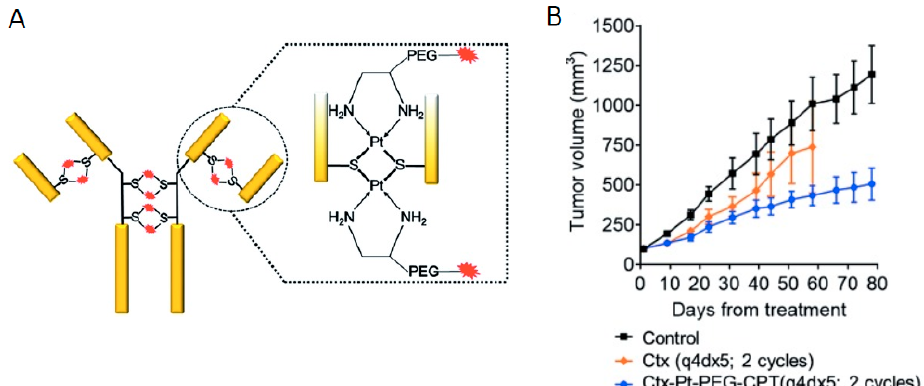
Figure 8. ( A ) Pt(II)-linker re-bridges the antibody chains with strong Pt–S interaction imparting stability, homogeneity and site-specificity. ( B ) In vivo efficacy of the Ctx–Pt–PEG–CPT treated animals showed significant differences in tumor volume compared with the control group ( p < 0.016), with a tumor growth inhibition (TGI) of 55%. Reprinted with permission from reference [119].